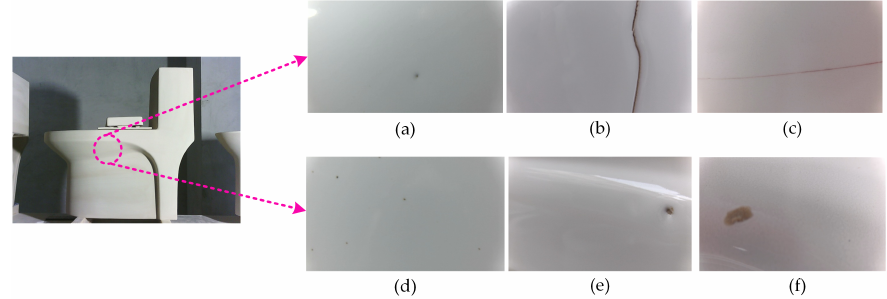
Figure 7. Defective sanitary ceramics. ( a ) Pinhole, ( b ) hard crack, ( c ) crack, ( d ) spot, ( e ) pit, ( f )